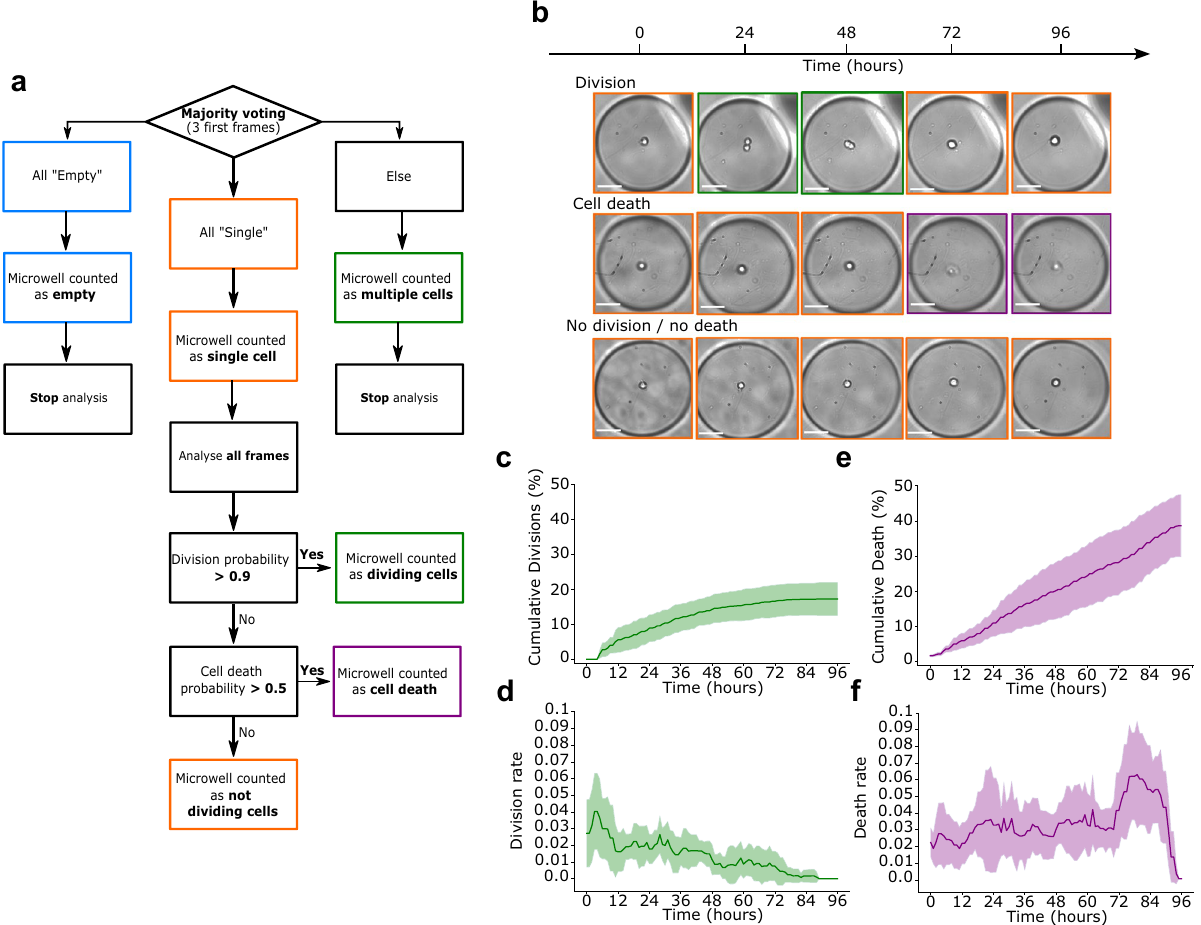
Figure 4. Dynamic analysis with our DLBA. ( a ) Downstream of the CNN, a decision tree considers the temporal information of cell time-lapses in order to detect single cells, cell divisions and cell death. First, we performed a majority voting on the first three frames for each microwell. If all these three frames were classified as “Empty”, the microwell was considered as containing no cell and its time-lapse was not further analysed. Then, if any of these three first frames was classified as “Multiple” or “Death”, the microwell was respectively considered as containing multiple cells or dead cells and was discarded from further analysis too. Finally, if all the three first frames were classified as “Single”, the microwell was considered as containing a single cell and the analysis kept on going. Among each time-lapse with an initial single cell, if two frames were classified as “Multiple” with a probability> 0.9 (of which one>0.99), we considered that a cell division occurred in the microwell. Else, if any frame was classified as “Death” with a >0.5 probability, we considered that a cell death occurred in the microwell. In any other case, we considered that there were still a living yet non-dividing cell in the microwell. ( b ) Examples of Time-Lapse images displaying cell division, death or neither of the two. Scale bars: 50 µ M. Cumulative dynamics of N14-0510 cells divisions ( c ) and cell death ( e ) were computed over time. Relative division rate ( d ) and death rate ( f ) were computed, over sliding 6-h temporal windows. Plots show means and standard deviations, over 4 experiments with three replicates each (2780 time-lapses analyzed in Because the low number of late divisions (after 60 h) was overwhelmed by the initial numbers of single cells, computing dynamics did not allow a clear view of the latest divisions. In order to emancipate from the initial number of single cells, we have plotted the instantaneous division rate (Fig. 4b and d). The initial division rate was circa 0.03 division/hour, but interestingly, it was decreasing over time. Regarding cell death, 38% (±9%) of single cells died during the 96-h time-lapse (Fig. 4b, e). Compared to cell proliferation rates, the dynamics of cell death rather seemed linear, suggesting that instantaneous death rates should be relatively stable over time. Indeed, the instant death rate was constant circa 0.03 death/hour, but it seemed to transiently increase after 72 h (up to 0.07 death/hour) (Fig. 4b, f). Taken together, these results show that for the cell line tested, our DLBA can track automatically single cell fate and follow dynamics of cell phenotypes over time at high throughput rate using brightfield microscopy.